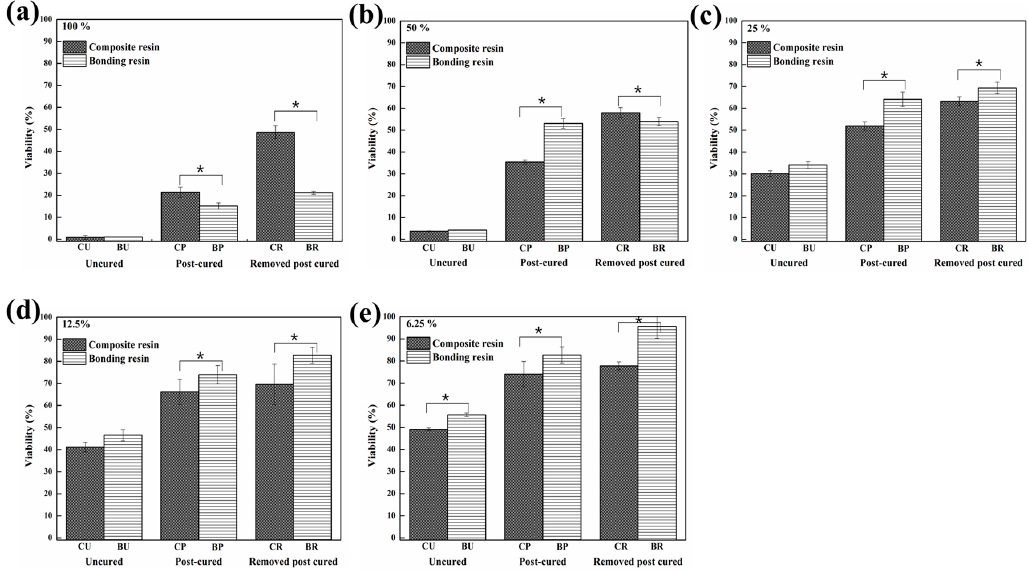
Figure 4. Cell viability following exposure to the extracts from the composite resin and bonding resin at different dilutions: ( a ) 100% concentration; ( b ) 50% concentration; ( c ) 25% concentration; ( d ) 12.5% concentration; ( e ) 6.25% concentration (*: Statistically significant at p < 0.05).